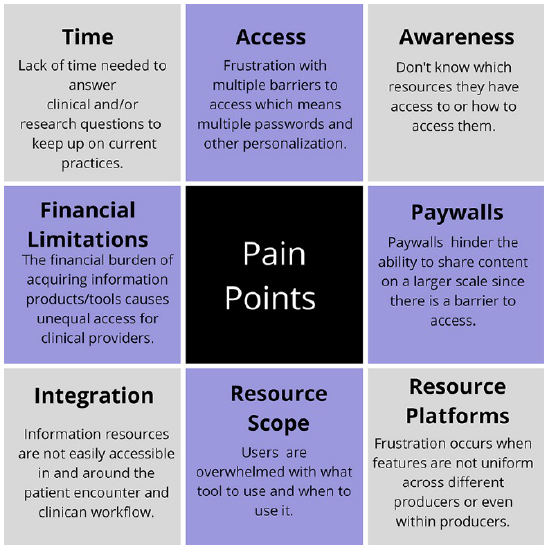
Figure 1 Descriptions of eight pain points that users experience when they try to access information in a clinical